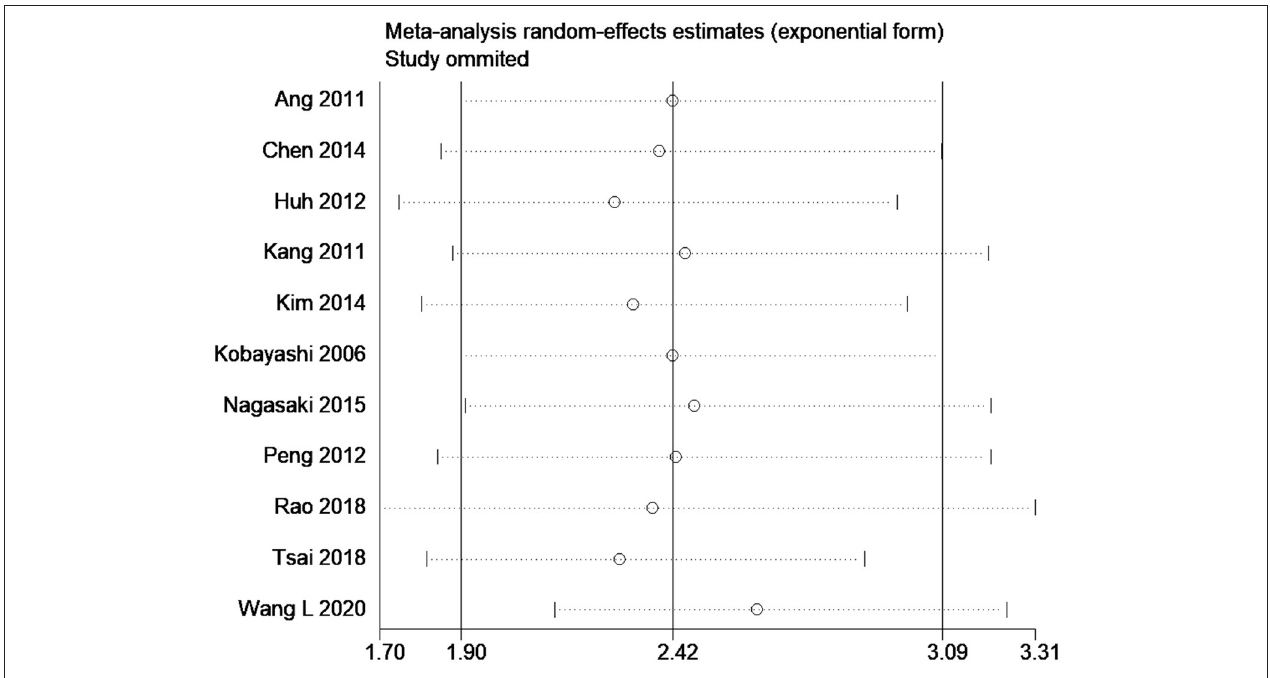
FIGURE 7 | Sensitivity analysis for disease-free